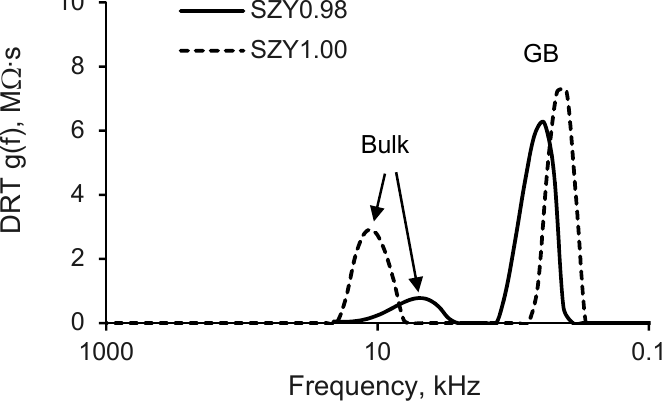
◦ C in air (pH = 40 2 O